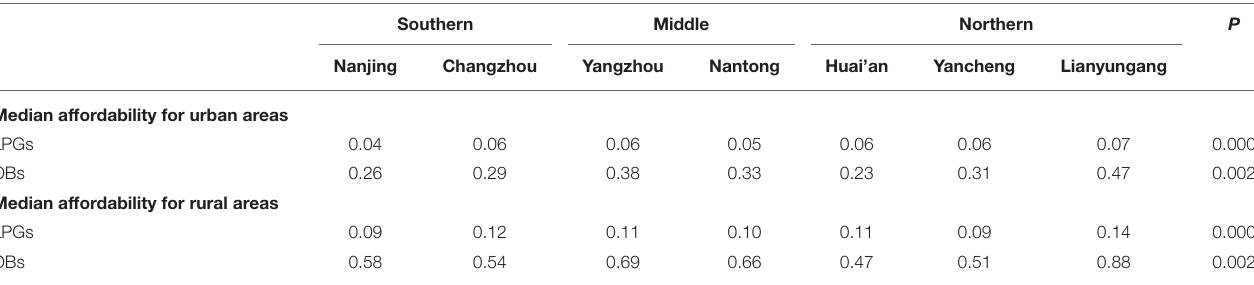
TABLE 8 | Median affordability of essential medicines in seven